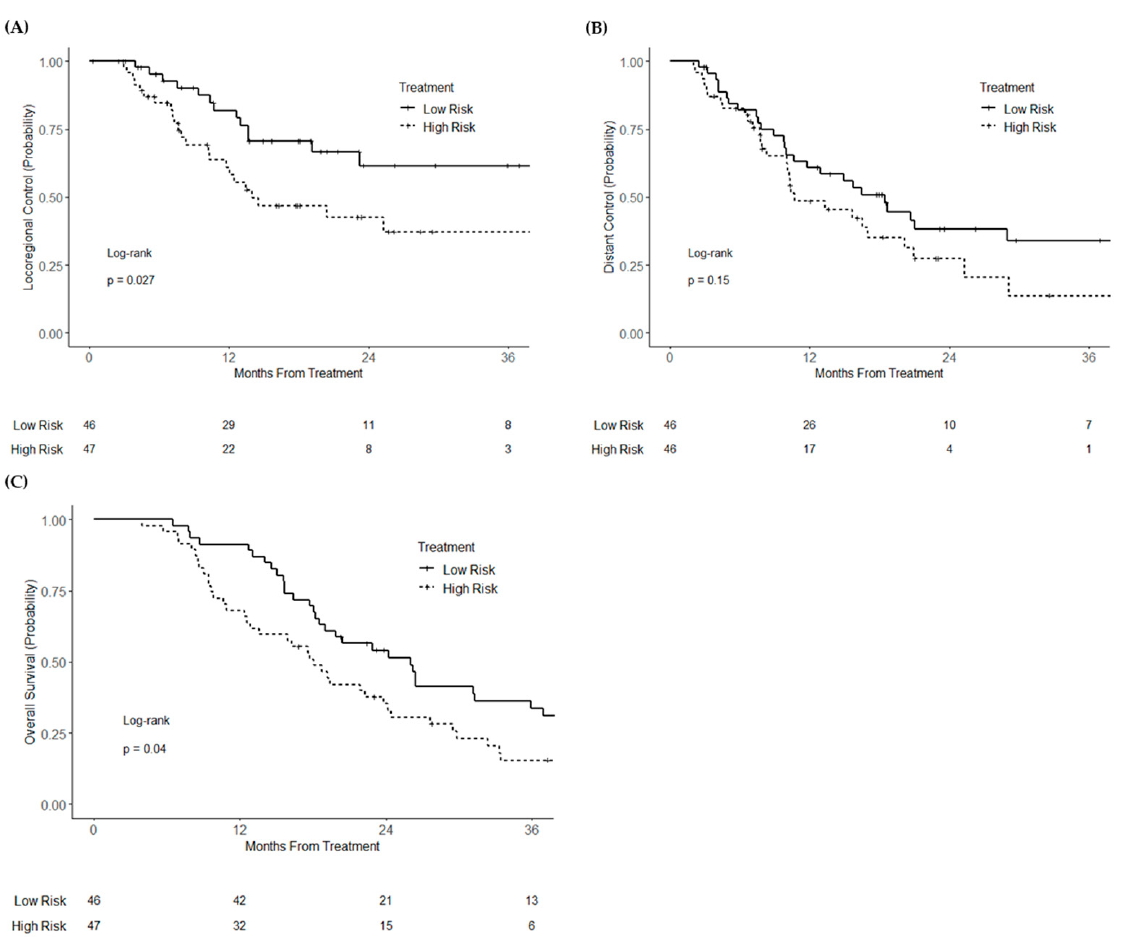
Figure 2. Kaplan–Meier curves of ( A ) locoregional control, ( B ) distant control, and ( C ) overall survival of the validation cohort of resectable pancreatic cancer patients, stratified by risk score group.